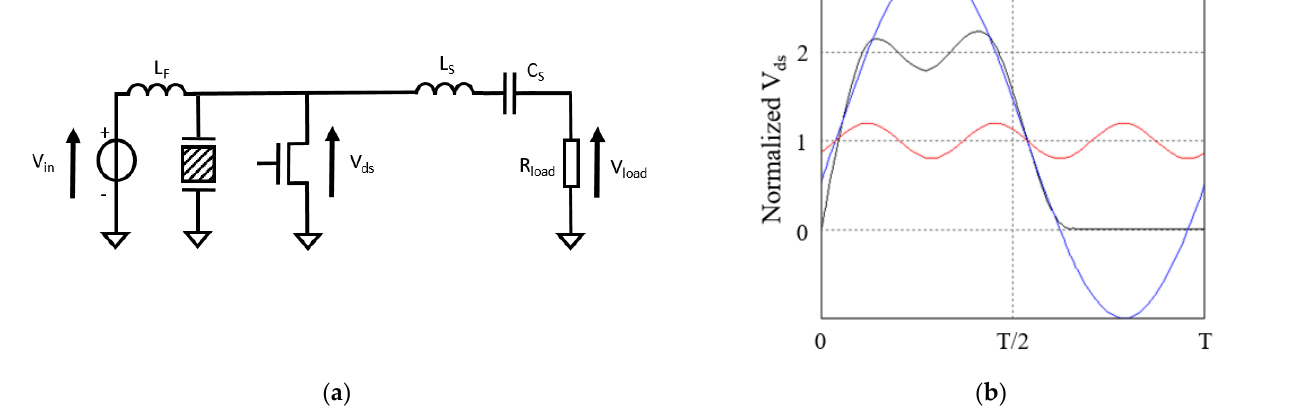
Figure 1. Schematic of an L − Piezo class inverter ( a ), and typical drain voltage ( V ds ) of class L − Piezo inverter and its harmonics ( b ).